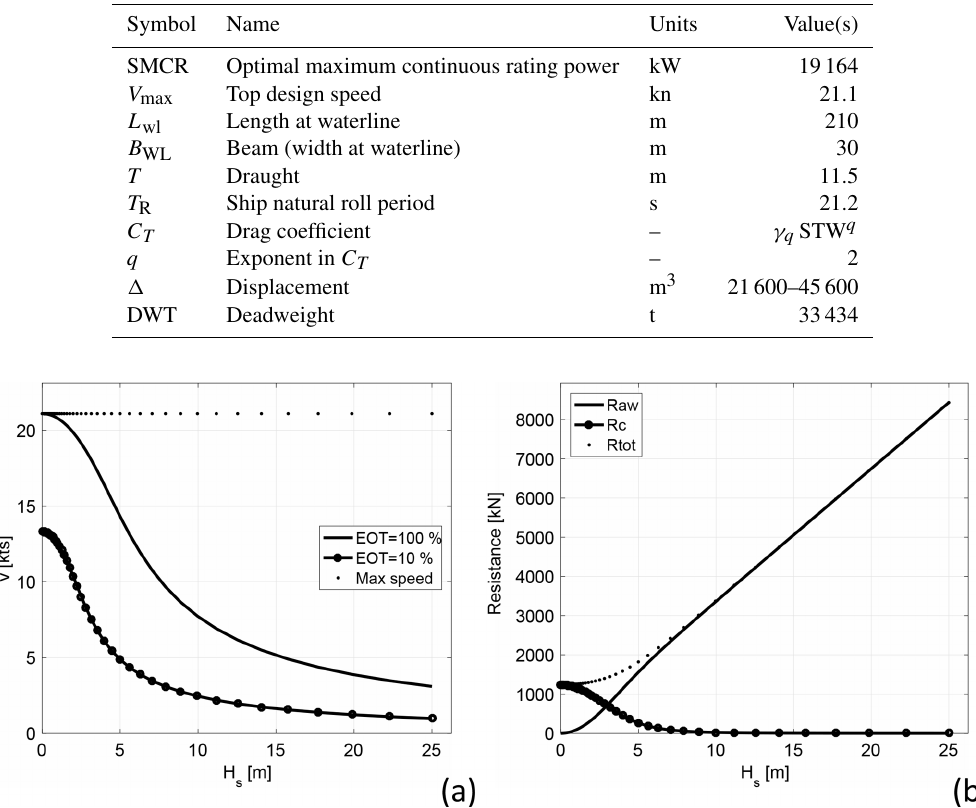
Table 4. Database of vessel propulsion parameters and principal particulars used in this work. The values of (cid:49) (ballast minus scantling range) and the maximum cargo capacity (2500 TEUs – 20ft equivalent units) are not used in the computations and are provided just for the sake of reference.